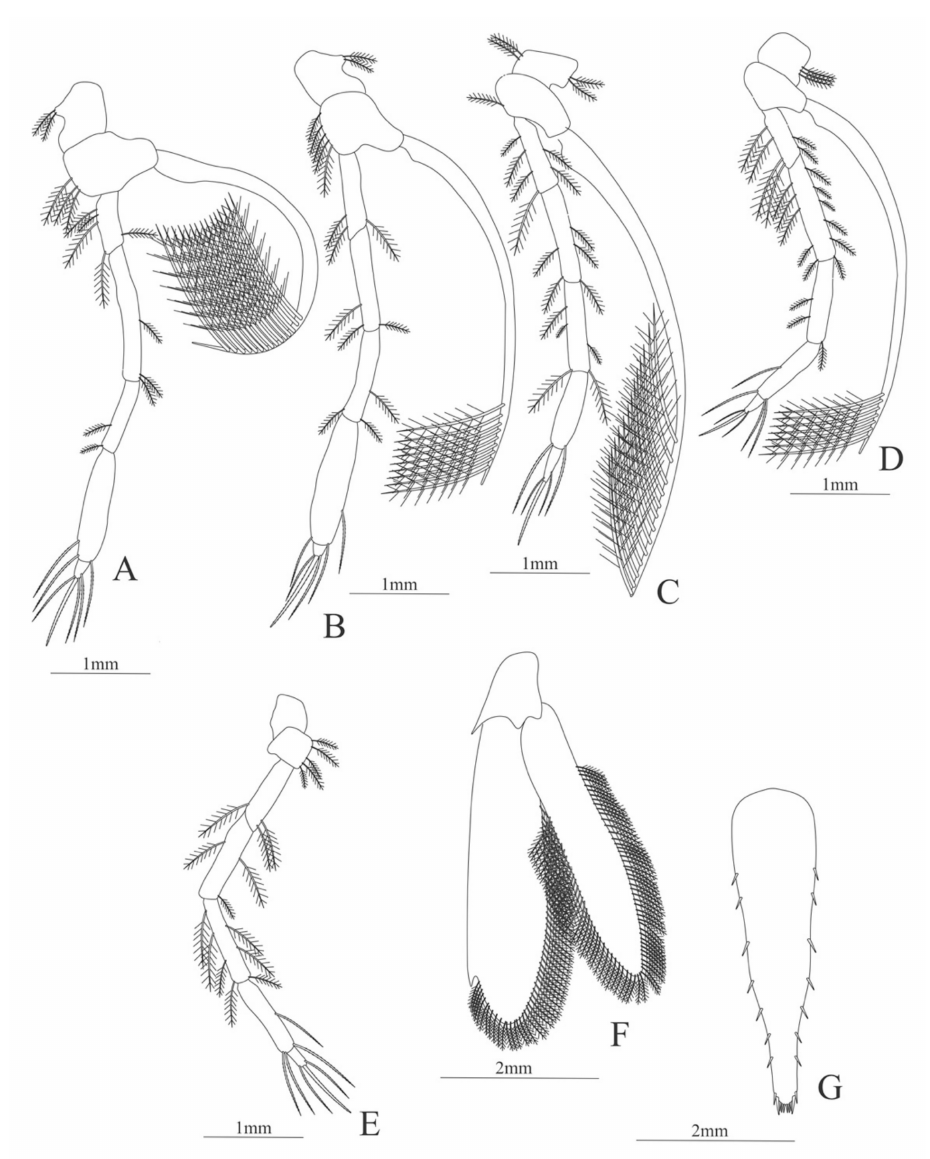
Figure 13. Nematocarcinus cursor : ( A ) first pereopod; ( B ) second pereopod; ( C ) third pereopod; ( D ) fourth pereopod; ( E ) fifth pereopod; ( F ) uropods; ( G ) telson. Nematocarcinus